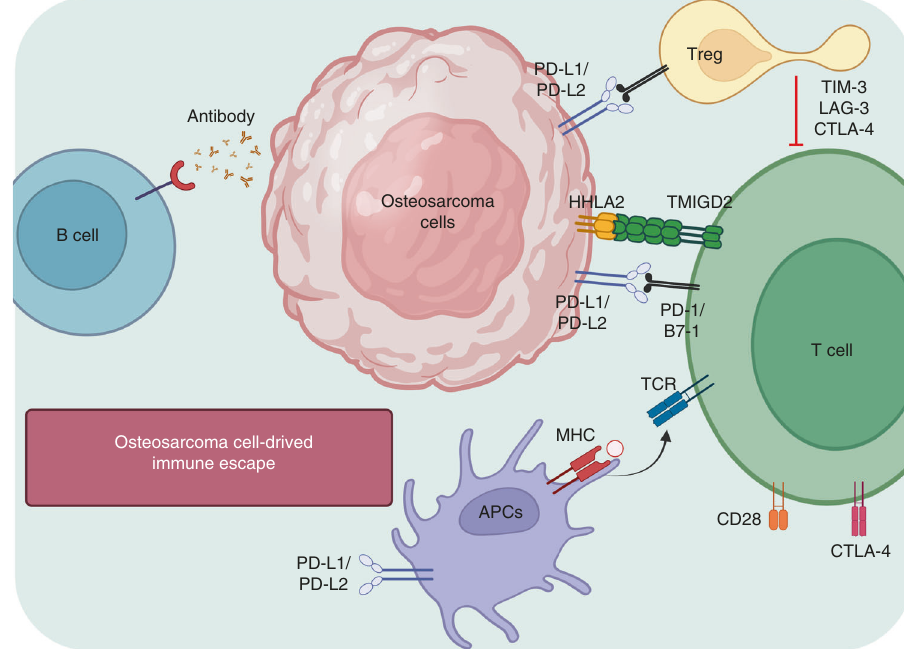
Fig. 3 Schematic illustration of immune checkpoints and the interplay between immune cells and osteosarcoma